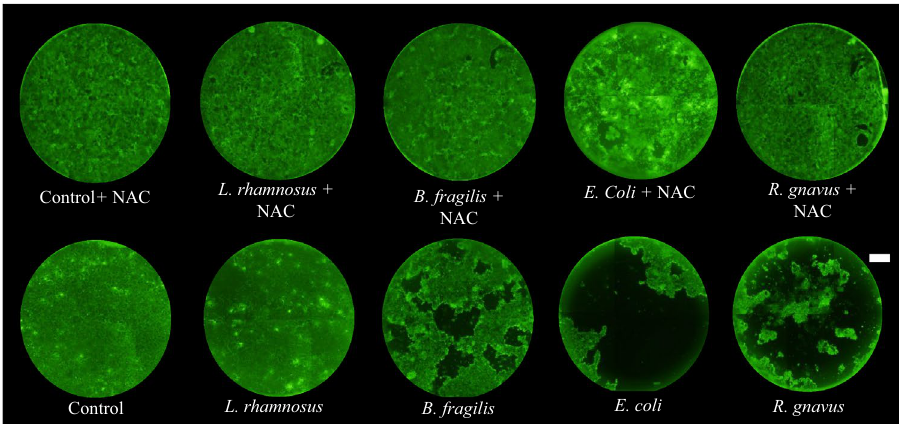
Figure 6. Apical supplementation of NAC improves monolayer viability. Representative Calcein AM stained images of NAC supplemented co-cultures and non-supplemented cultures (scale bar = 1